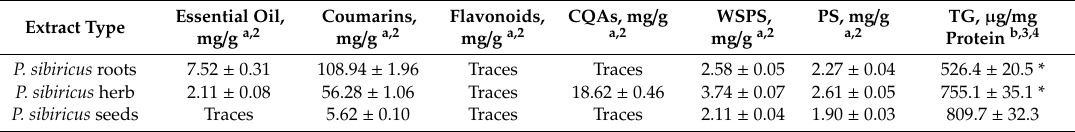
Table 1. Total content of essential oil, coumarins, flavonoids, ca ff eoylquinic acids (CQAs), water-soluble polysaccharides (WSPS) and pectic substances (PS) in Phlojodicarpus sibiricus organs and triacylglycerol (TG) content in 3T3-L1 adipocytes after incubation with P. sibiricus extracts 1 . Extract